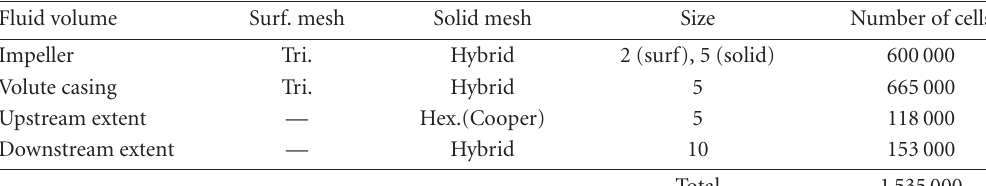
Table 2: Mesh characteristics.